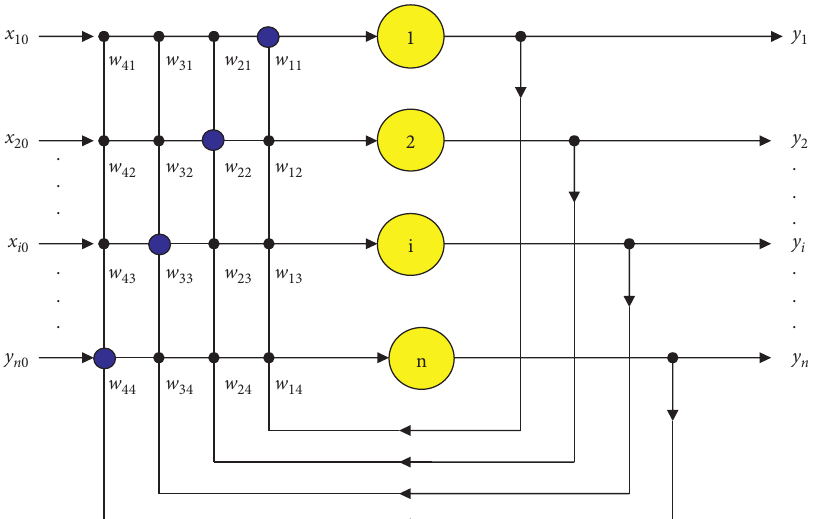
Figure 3: Hopfield neural network in the problem of SERP ranking ( x : input search requests within a separate DIRS, y : neuron outputs, and w : values of offsets and synaptic connections).